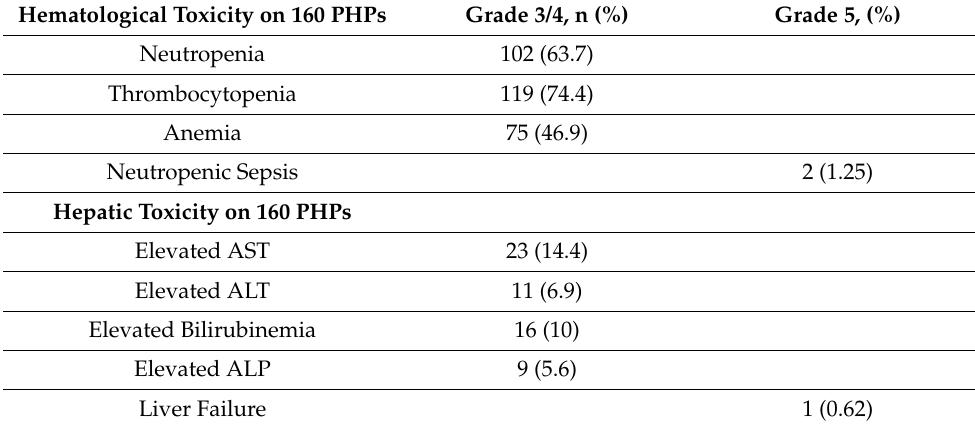
Table 3. Grade 3/4 and Grade 5 treatment related hematological and hepatic toxicity as experienced by a selection of 55 patients who performed 160 treatments within clinical trials or following standard